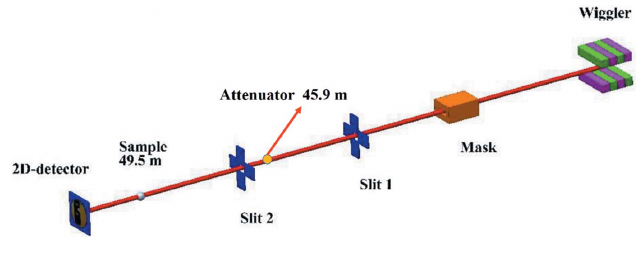
Figure 2 PXM in white-beam mode: the mask is at 24.3 m, the white-beam slit-1 is at 26 m, and the white-beam slit-2 is at 46.5 m.